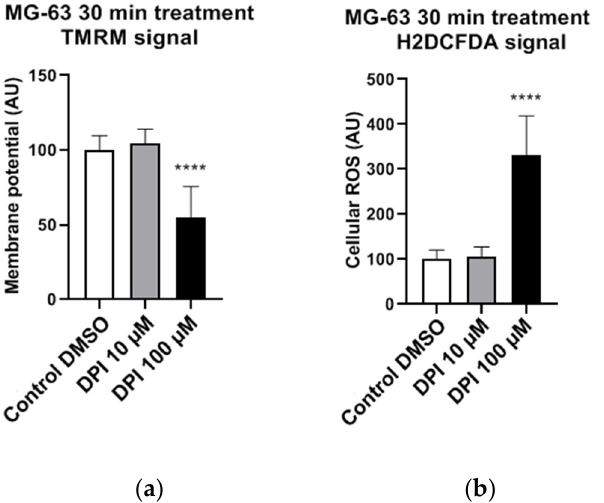
Figure 2. Effects of 30 min 10 µM and 100 µM diphenyleneiodonium chloride (DPI) in nonperme- abilized MG-63 cells, inducing a drop in mitochondrial membrane potential and a burst of reactive oxygen species (ROS) production on higher concentrations. The data is displayed in arbitrary units (AU). ( a ) Effects of 10 µM and 100 µM DPI on mitochondrial membrane potential. ( b ) Effects of 10 µM and 100 µM DPI on cellular ROS levels. Data is represented as means + SD (error bars) ( n = 24; each point was obtained by analyzing 2–4 single cells. **** p < 0.0001; one-way ANOVA followed by multiple comparison post-hoc Fisher’s LSD test.).